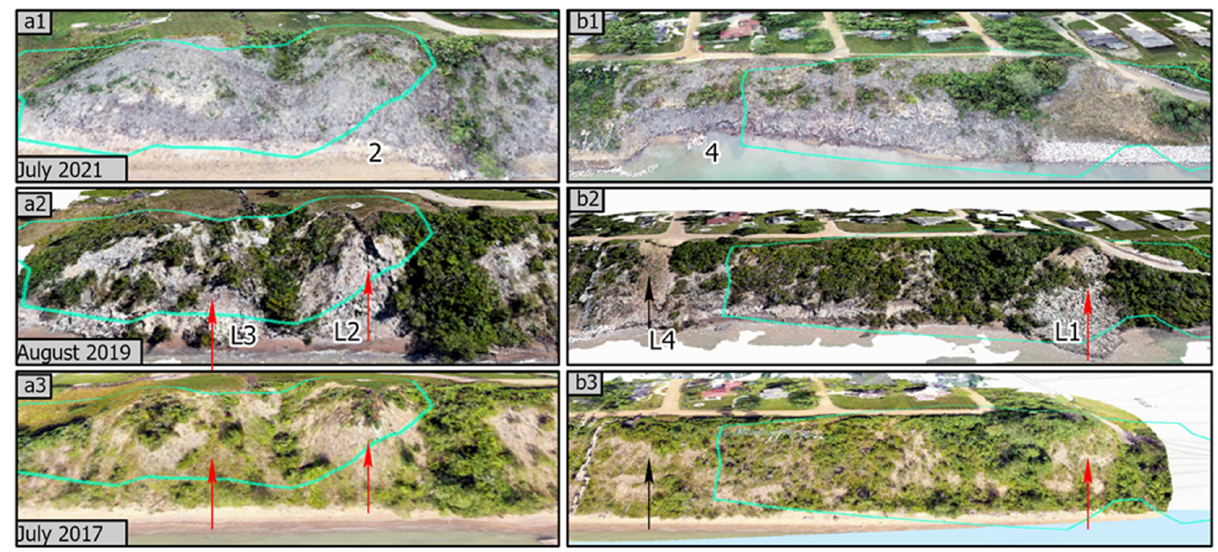
Figure 9. Enlargements of the UAV orthomosaic images draped over a DEM for the areas outlined by red boxes in Figure 8. The images are for the areas occupied by anomaly 2 (2021: a1 ; 2019: a2 , and 2017: a3 ) and anomaly 4 (2021: b1 ; 2019: b2 ; 2017: b3 ). The figure shows the locations of landslides (L1, L2, and L3; red arrows) that developed between the 2017 and 2019 acquisitions in the entire study area, all of which lie within the regions occupied by anomalies 2 and 4 (green polygons), with one exception with limited size (L4; black